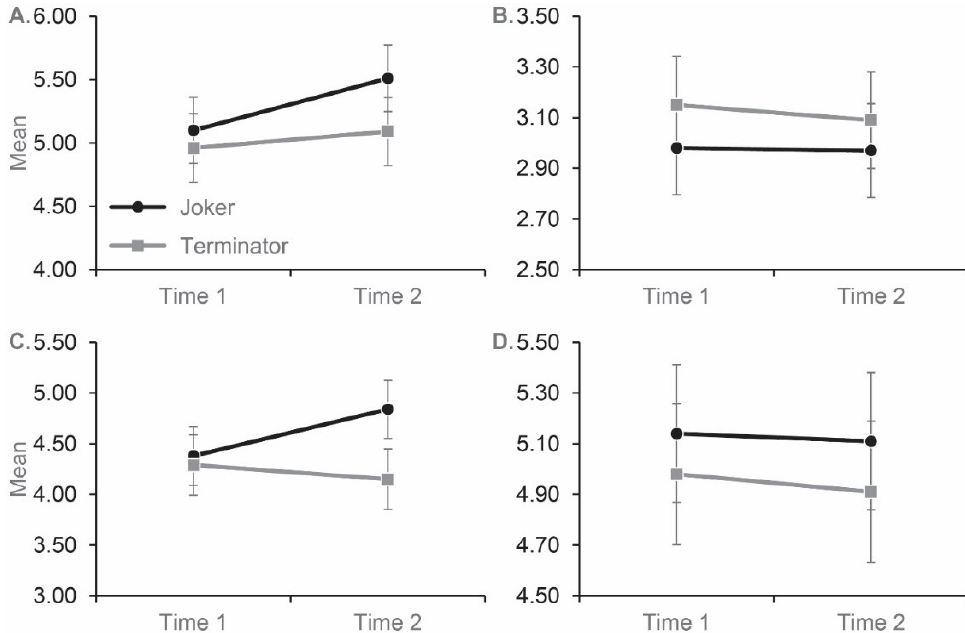
Figure 1 . Mean scores for participant in the experimental ( Joker ) and control ( Terminator ) conditions on the fear/avoidance ( A ), malevolence ( B ), authoritarianism ( C ) and unpredictability ( D ) subscales of the PPMI. The subscales were completed before (Time 1) and after (Time 2) each film. A total of 81 participants viewed Joker , and 80 viewed Terminator . Error bars represent ± standard error of the mean.